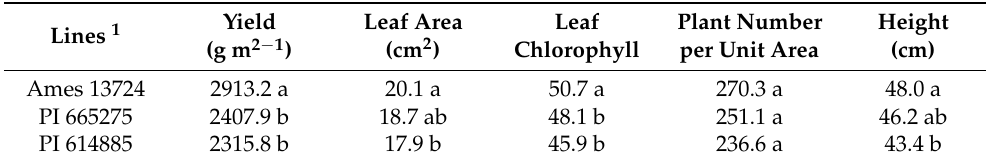
Table 3. Least-square means of yield (Yd), plant height (Ht), leaf area (La), leaf chlorophyll content (Ch), number of plants per unit area (Pn), and for three varieties of quinoa grown in the high tunnel for leafy greens production in 2020, 2021 and